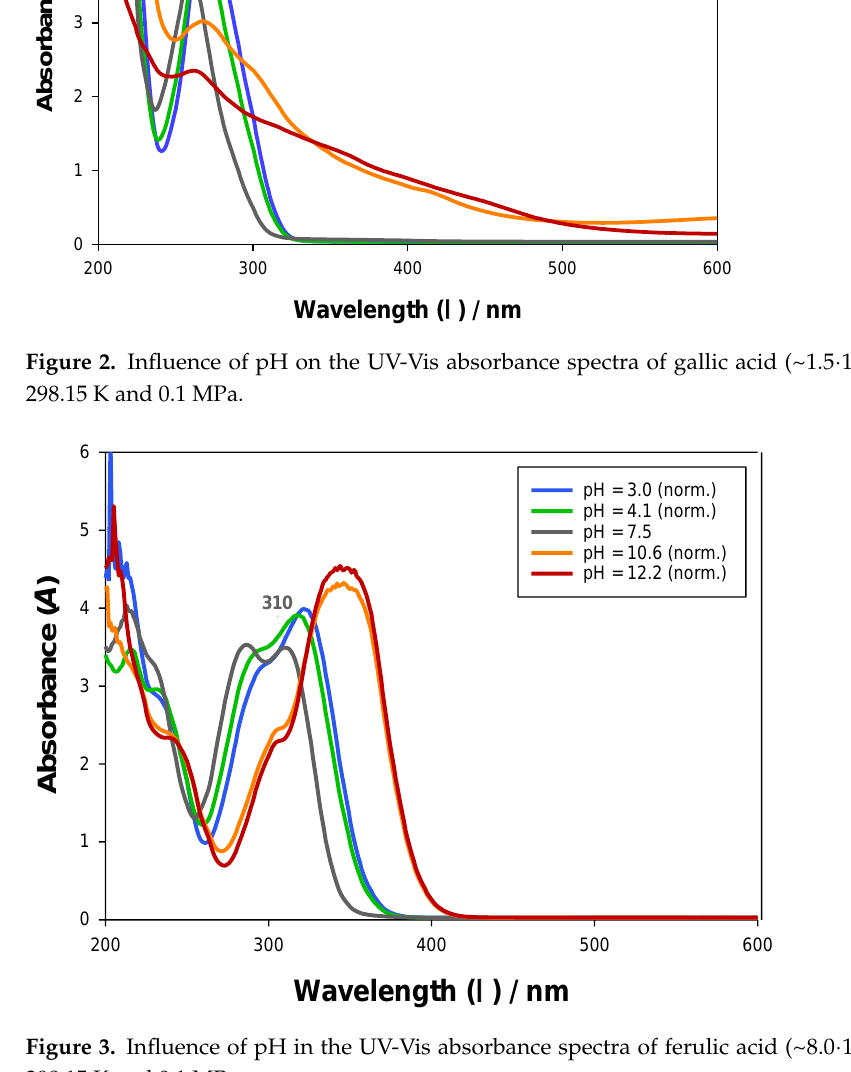
Figure 3. Influence of pH in the UV-Vis absorbance spectra of ferulic acid (~8.0·10 −5 g·mL −1 ) at 298.15 K and 0.1 MPa. Table 3. Stability of the UV-Vis absorbance spectra of gallic acid (GA) and ferulic acid (FA) after settling for 3 days at 298.15 K and 0.1